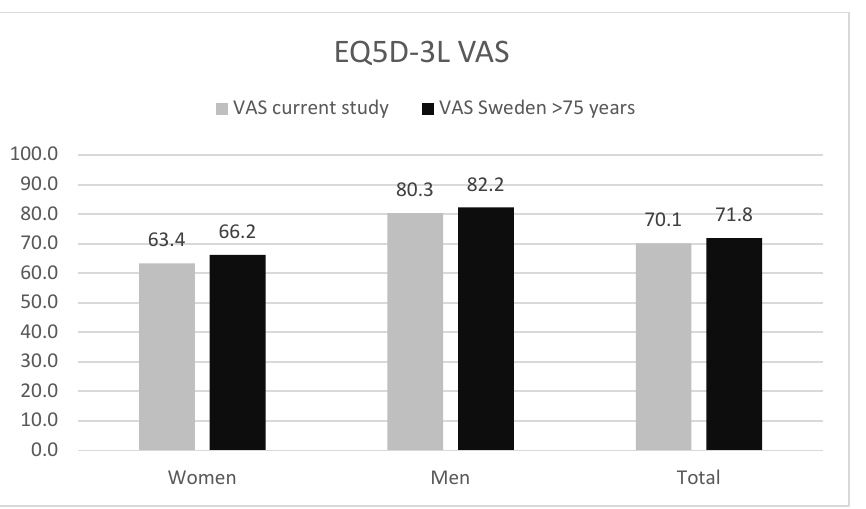
Figure 1. VAS from EQ5D-3L from this study and for an average Swedish population aged 75 and above [18]. The results are displayed in total and separated for men and women.